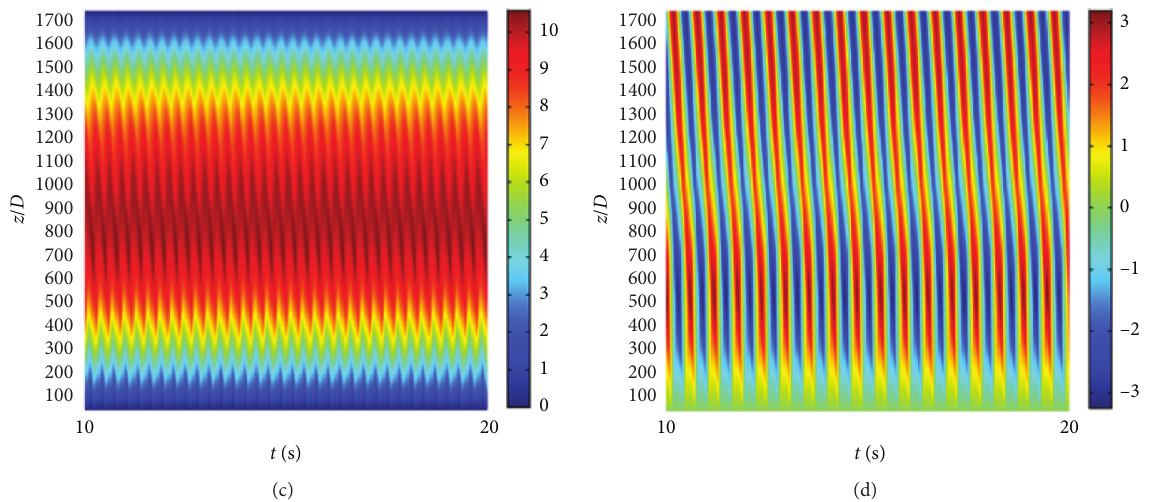
Figure 11: Space-time response of displacement under different axial tension excitation amplitudes. (a) The in-line and (b) cross-flow with A / D � 1.2. (c) The in-line and (d) cross-flow with A / D �